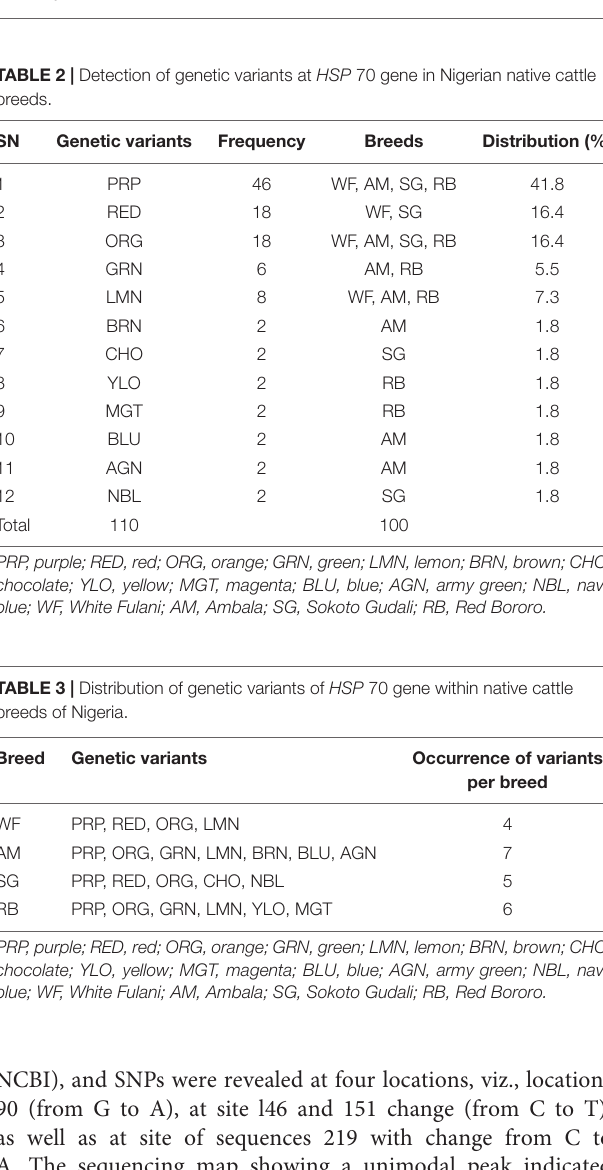
TABLE 2 | Detection of genetic variants at HSP 70 gene in Nigerian native cattle breeds. SN Genetic variants Frequency Breeds Distribution (%)